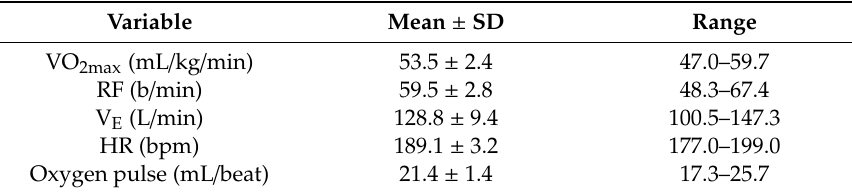
Table 1. Predicted VO 2max and some of the physiological variables at the level of the predicted VO 2max of the